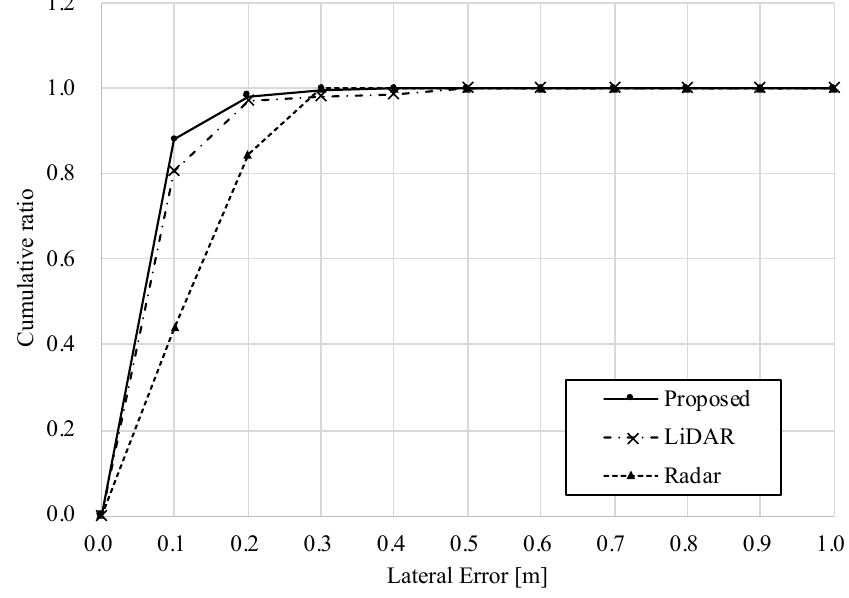
Figure 15. Lateral error in dry road surface